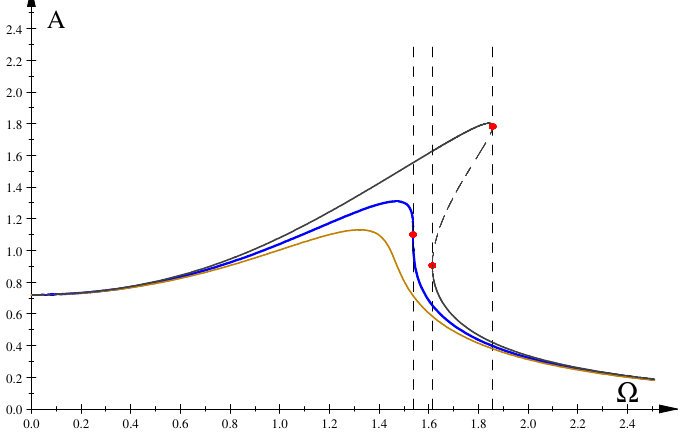
Figure 1. Amplitude profiles: critical (blue, h = h ∗ ), with two VTs (dark gray, h = 0.3; solid line—stable, dashed—unstable), and without VT (sienna, h = 0.65). Red dots show VTs. Coordinates of critical points ( Ω ∗ , A ∗ ) (red dots), computed from Equation (4a,b), are ( 1. 537, 1. 101 ) , ( 1. 615, 0.905 ) , ( 1. 857, 1. 782 ) . In critical points, metamorphoses